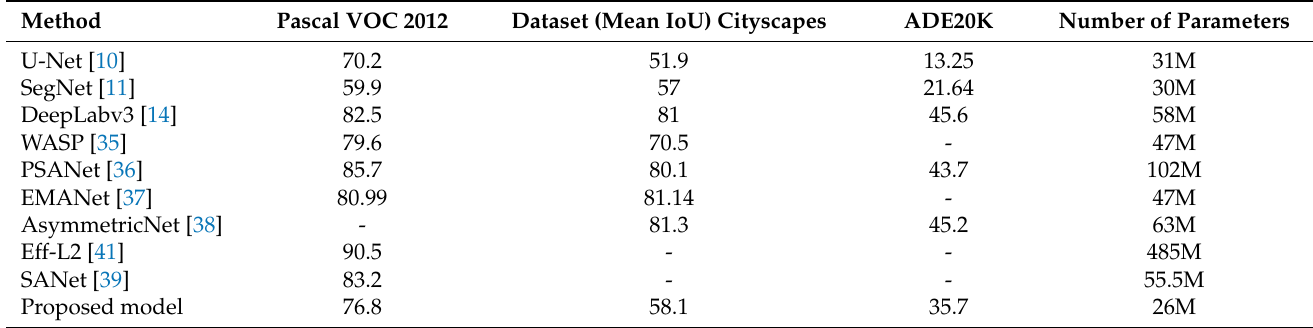
Table 18. Results compared with other models.